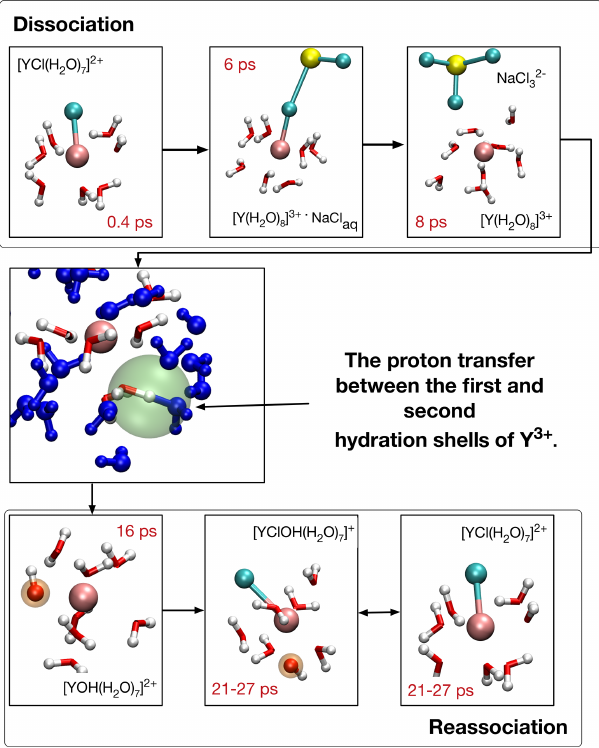
Figure 6. Formation of [ YOH ( H 2 O ) 7 ] 2 + and reassociation of ini- tial complex [ YCl ( H 2 O ) 7 ] 2 + in run # 13. The blue-colored water molecules are located in the second hydration shell, red–white H 2 O and OH − are bonded in the first coordination shell, and sodium is colored yellow. Chloride ions are in cyan and the Y 3 + ion is copper colored. The red numbers indicate the time progress in the AIMD simulation. In the center, the proton transfer state is highlighted with a green